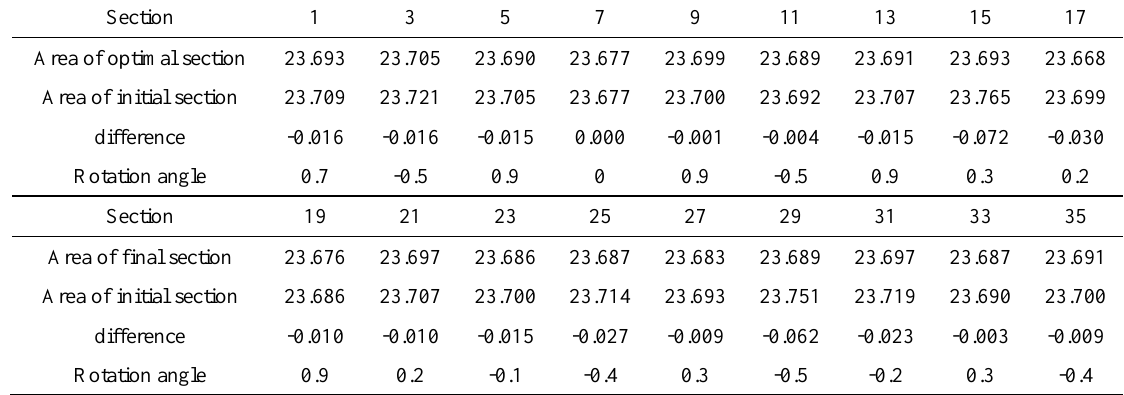
Table 2. Fine adjustment results of cross sectional point sets unit: m